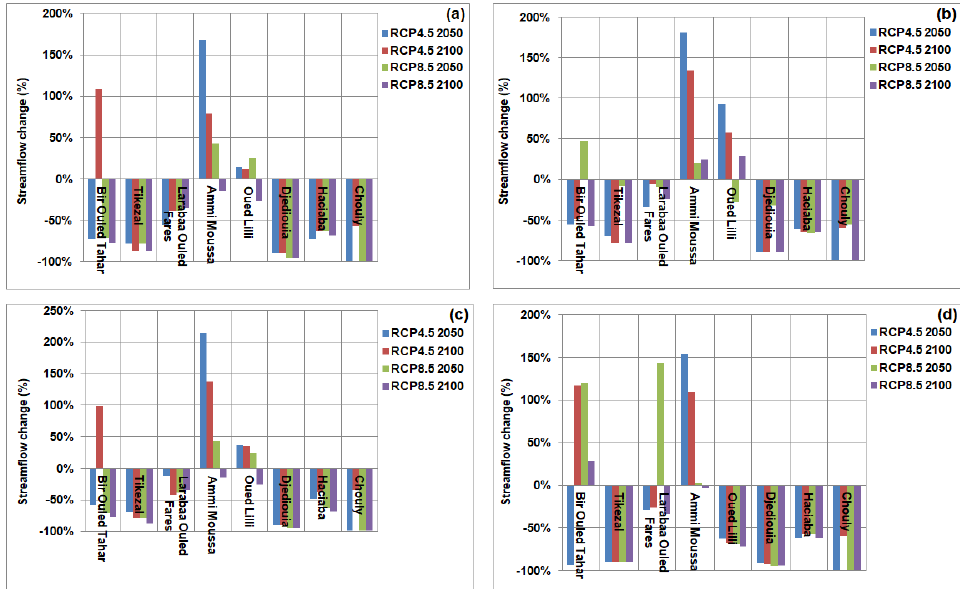
Figure 11. Changes in summer streamflow relative to the historical period under two scenarios (RCP4.5 and RCP8.5): ( a ) quantile mapping, ( b ) scaled distribution mapping, ( c ) quantile delta mapping, and ( d ) model RAW.